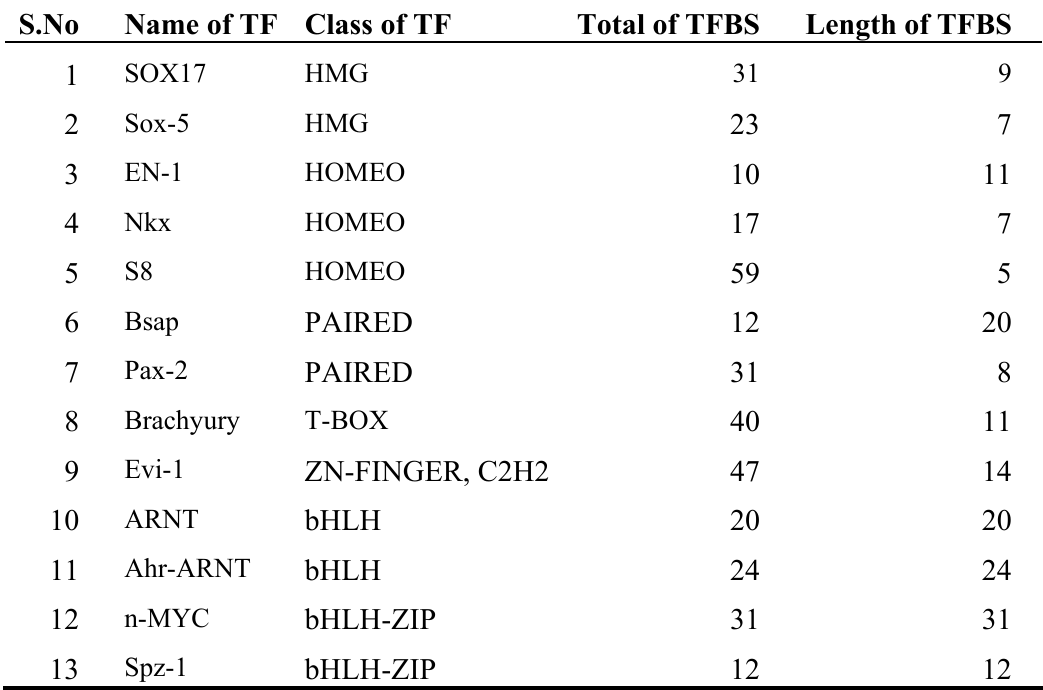
Table 3: Mouse transcription factors with the recognized TFBS and their lengths